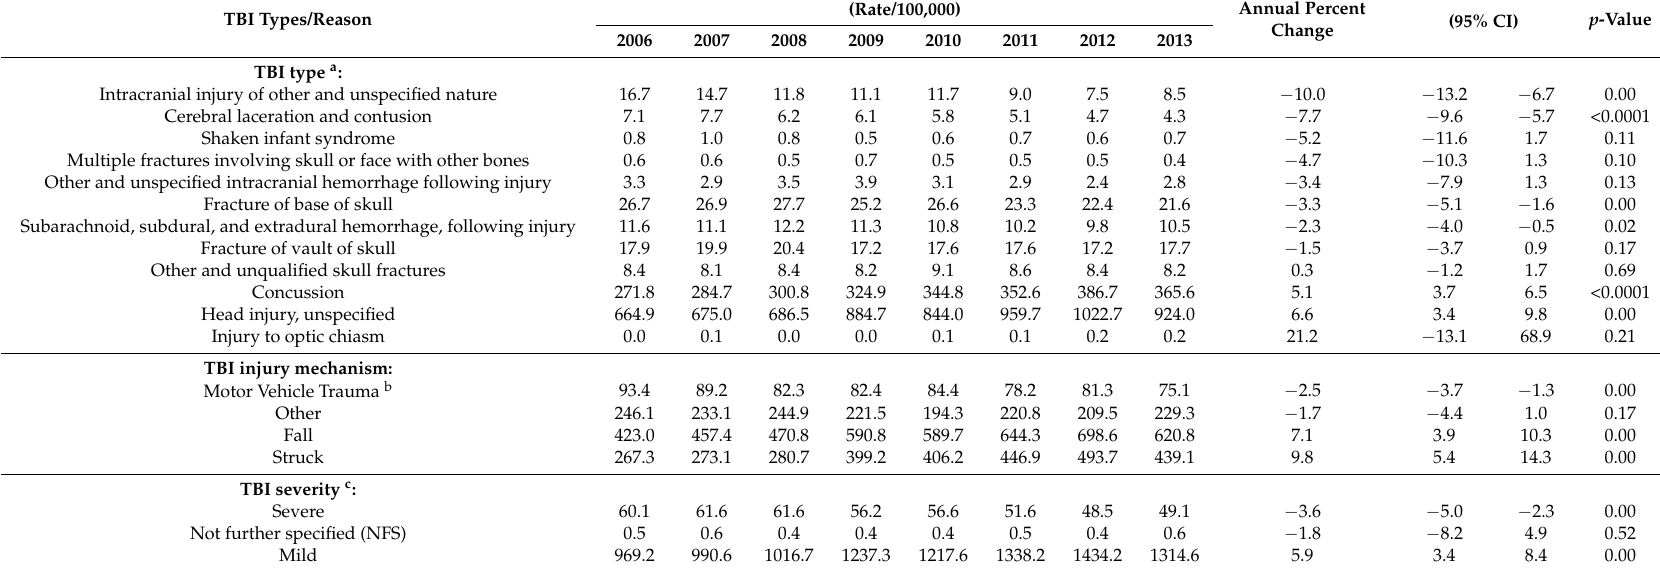
Table 2. Trend of age-adjusted rates of TBI-related ED visit by TBI type, injury mechanism, and severity in the U.S., 2006–2013,